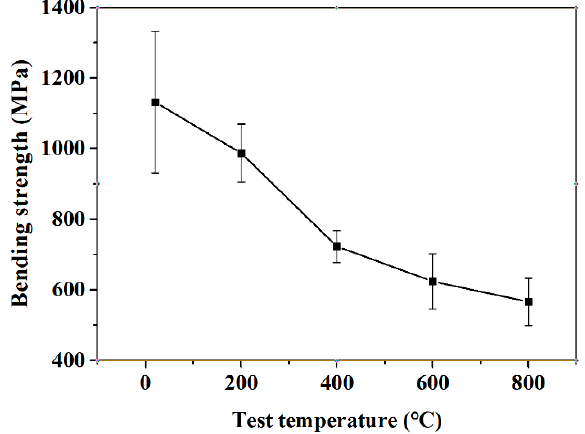
Figure 3. Bending strength of the Si3N4-based ceramic material containing 10 wt % WC and 1 wt % Co at different temperatures.